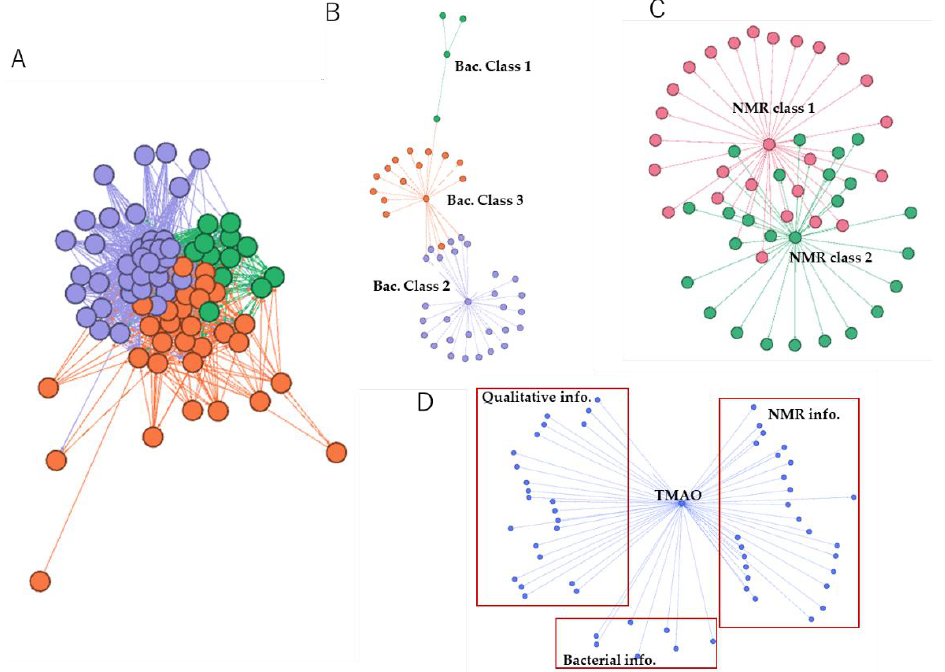
Figure 3. Association networks of association rule mining results constructed using zero-one- converted datasets. ( A ) Network of associations of high importance and annotated signals extracted from all associations. ( B ) Bacterial association network. ( C ) Associations determined from NMR data. The network hubs for B and C are class information determined by i-means. Both networks sometimes share some factors. ( D ) Depiction of some rules from some factors to trimethylamine oxide (TMAO).